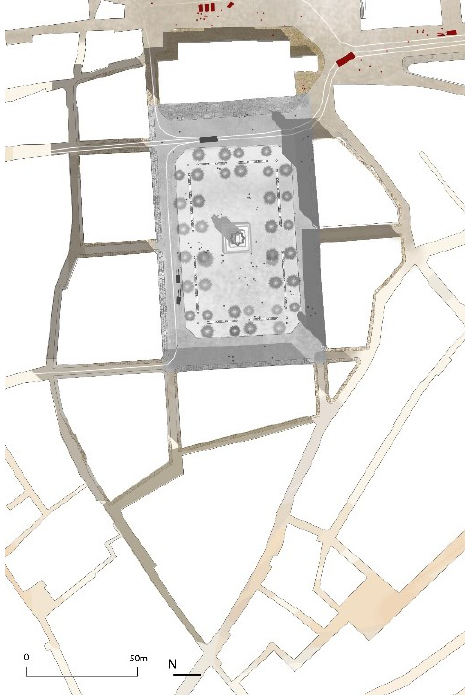
Figure 6. The square around 1930, with the silhouette of the two volumes grafted in the south sector visible through its